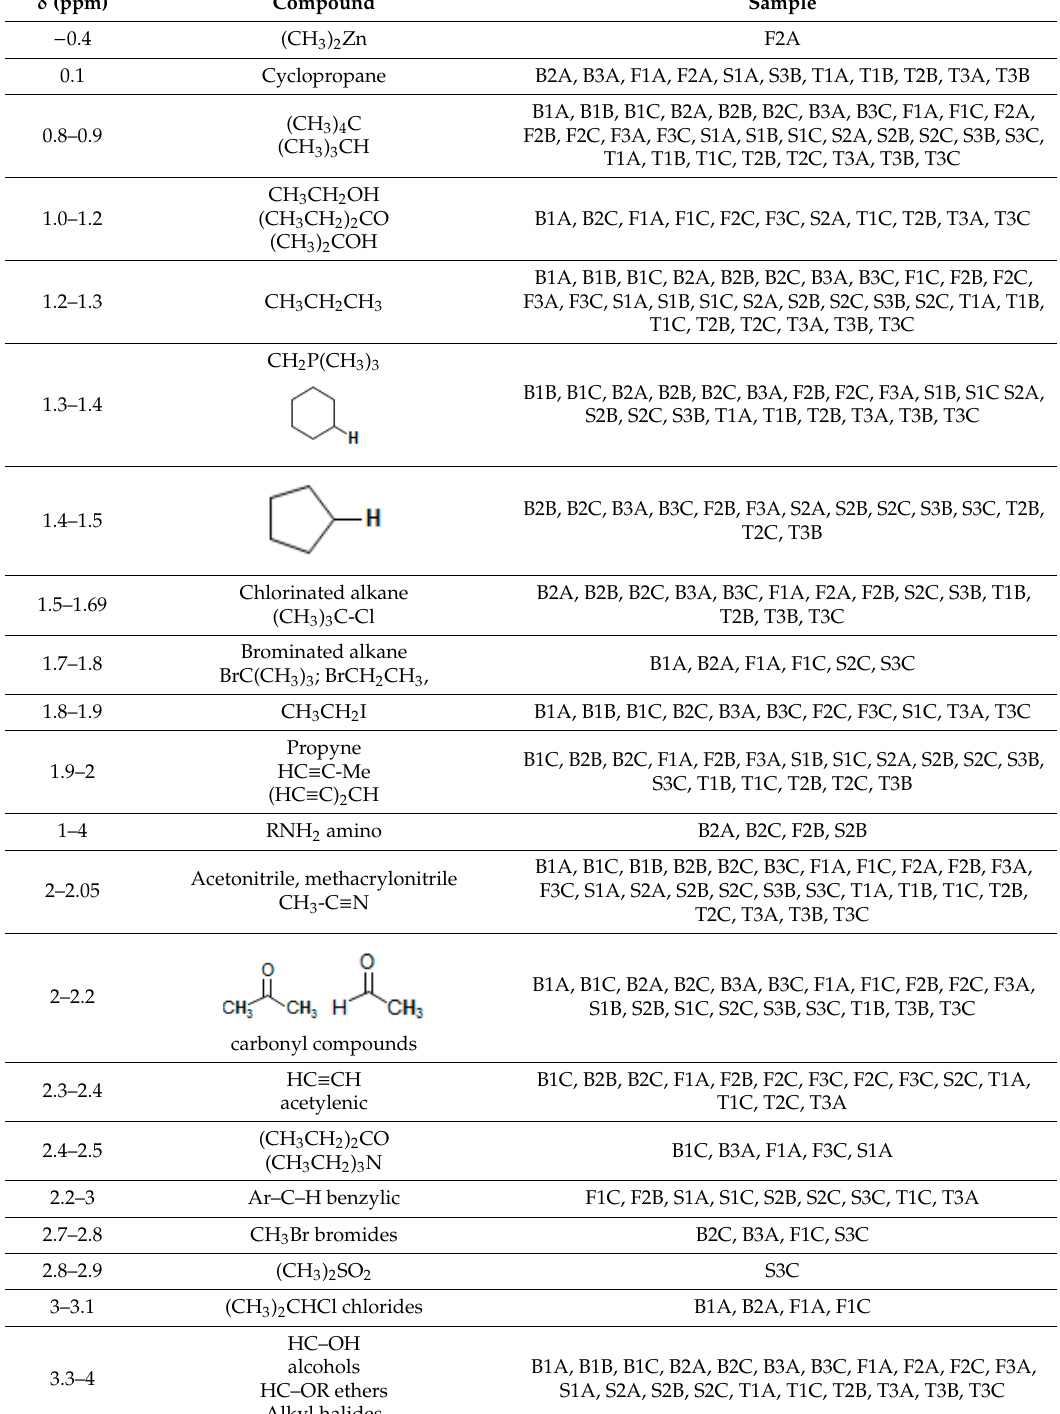
Table 1. 1 H-NMR chemical shifts (relative to TMS at δ = 0) of freshwater samples. The shifting proton is in bold.